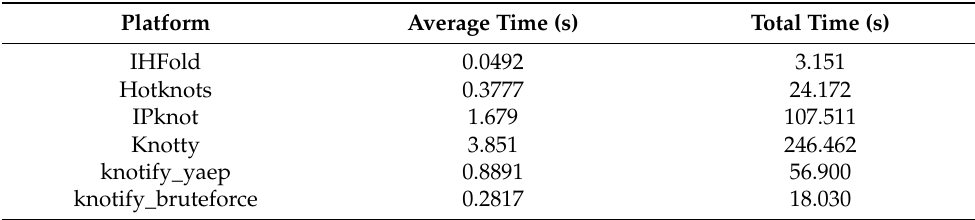
Table 14. Execution time required per platform in for RNA sequences of length > 50.